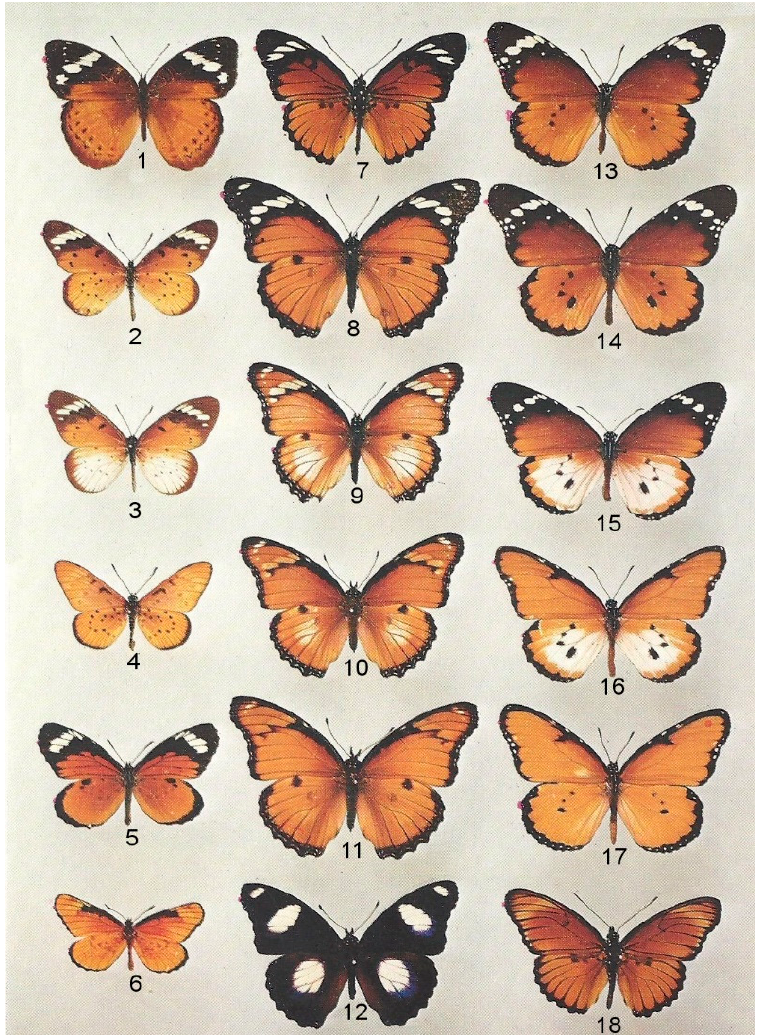
Figure 3. The comprehensive mimicry cycle based upon the colour forms of African Danaus chrysippus . 1 . Euriphene iris Aurivillius ( ♀ ) (female-limited Batesian mimic of 13–14); Mpala, Congo Republic. 2 . Acraea encedon L., form encedon ( ♀ ) (Müllerian mimic of 13–14); Kampala, Uganda. 3 . A.